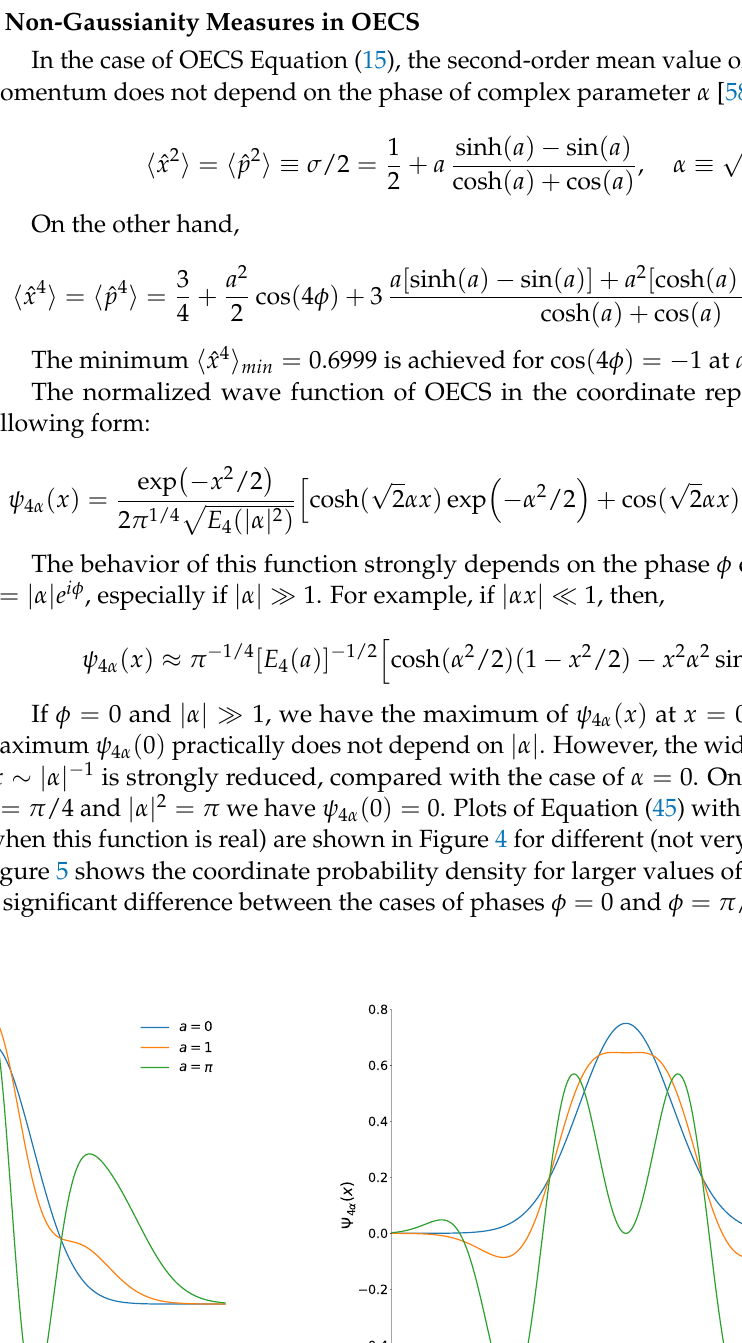
Figure 4. Real wave functions of OECS for different values of parameter α =